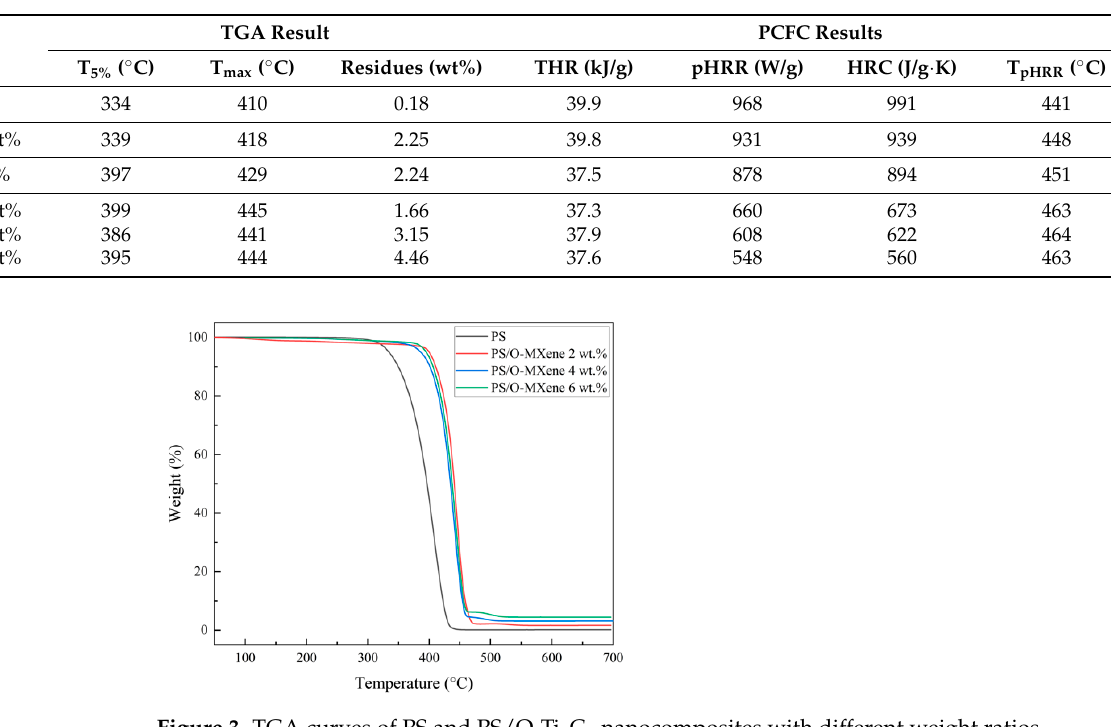
Table 1. TGA and PCFC results of PS and its different nanocomposites.